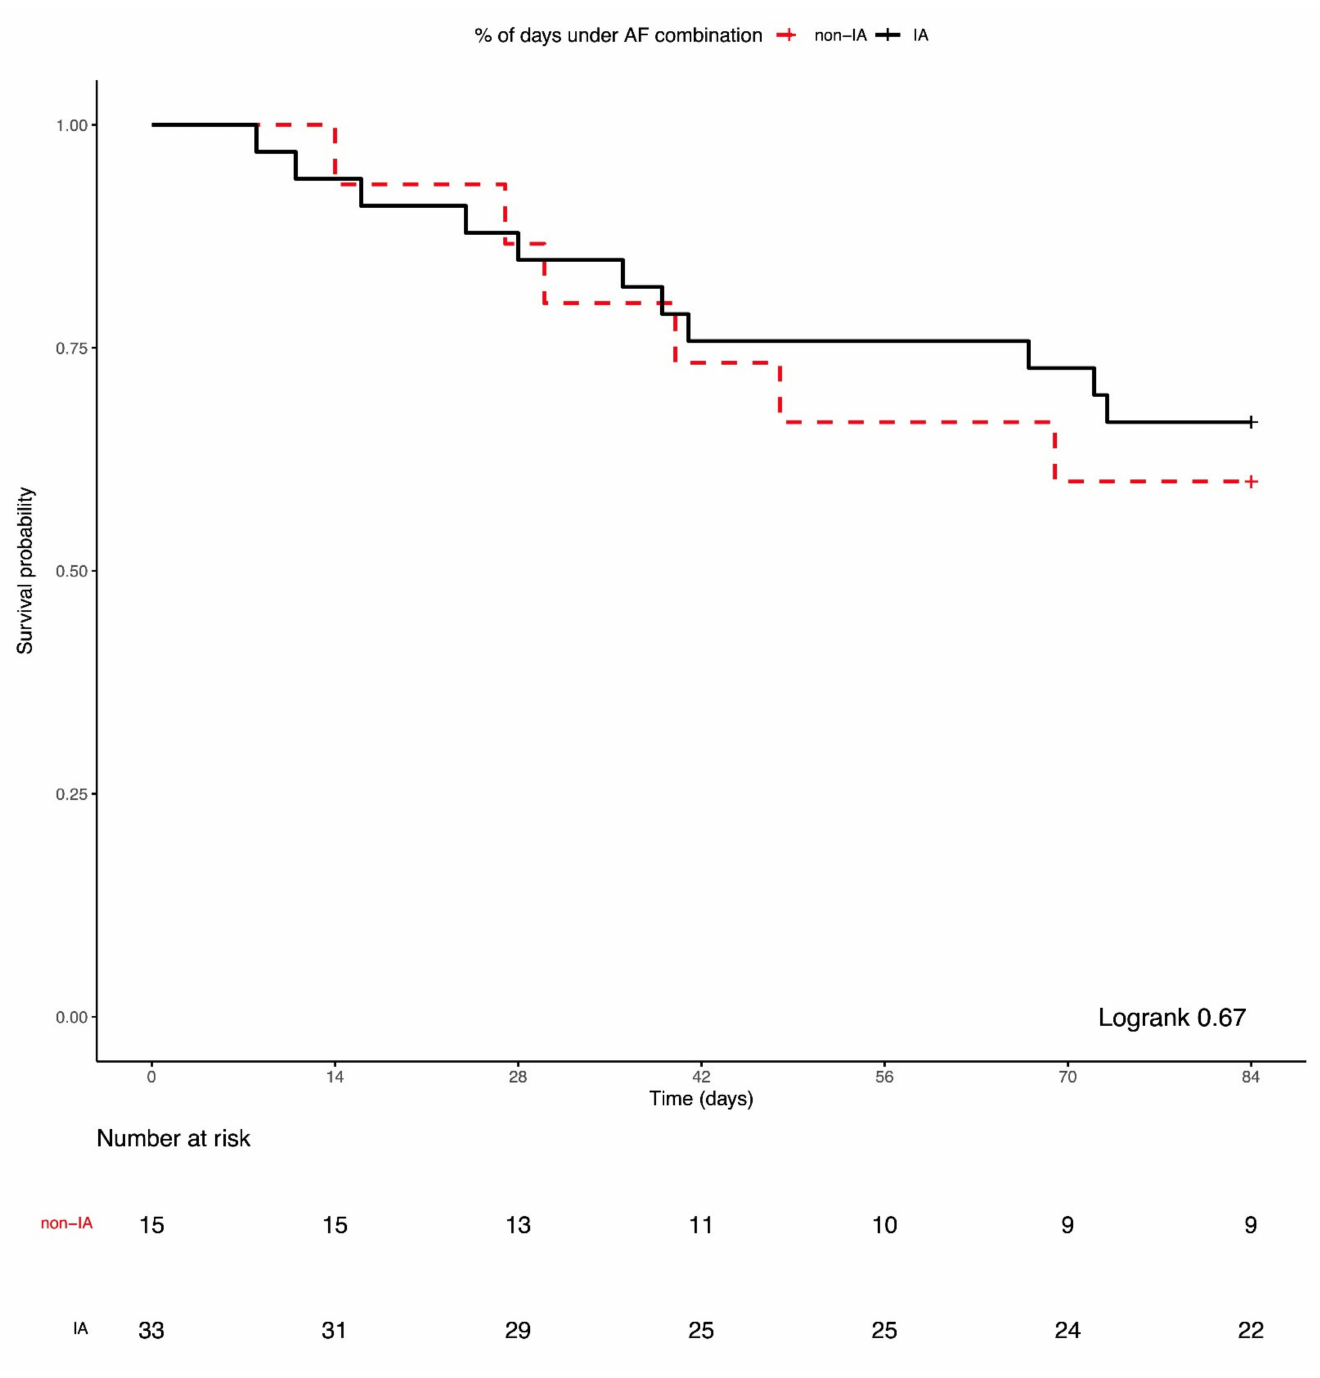
Figure 2. Kaplan–Meier survival curves of all-cause 12-week mortality after the diagnosis of an invasive mold infection (IMI) according to IMI type: invasive aspergillosis (IA) vs. non-IA